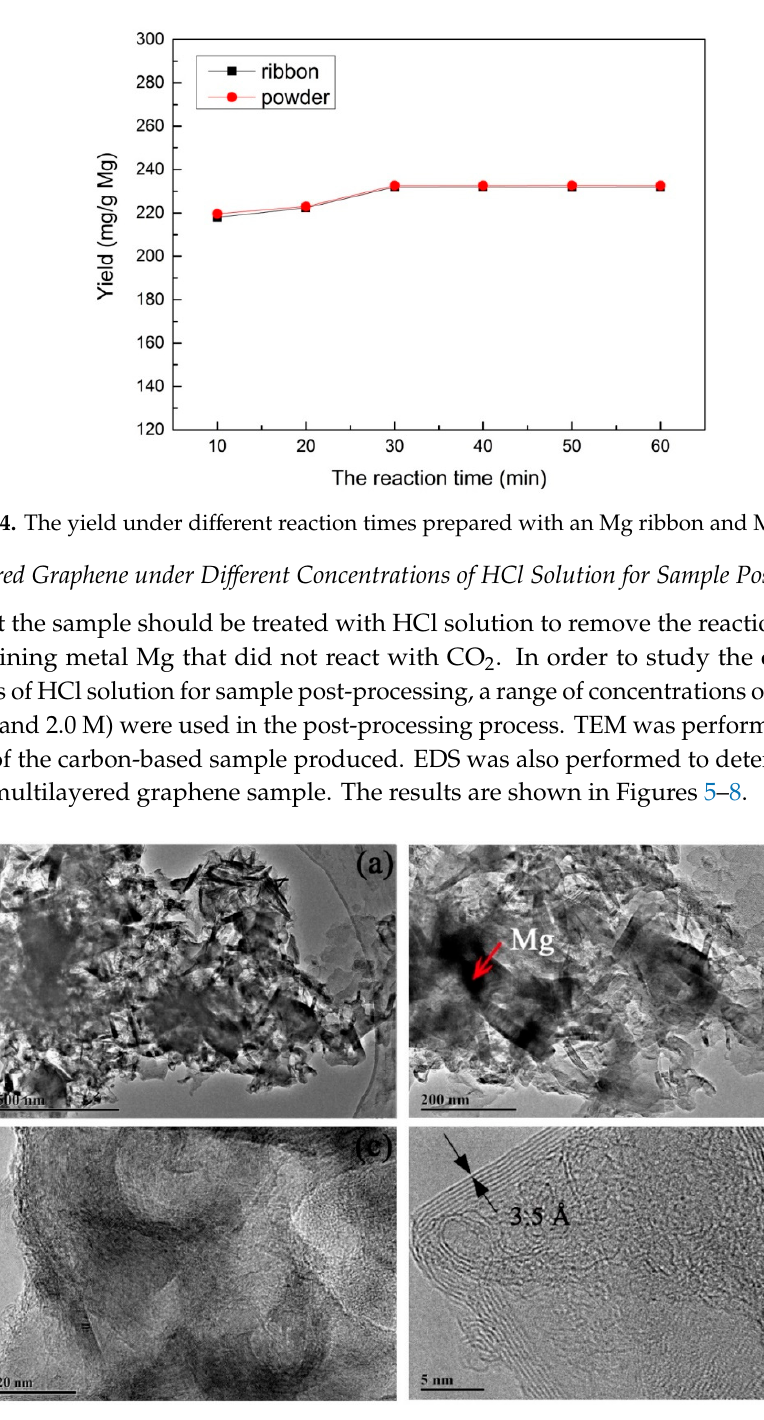
Figure 5. Transmission electron microscopy (TEM) images of multilayered graphene treated with 0.5 M concentration of HCl. ( a ) Thin graphene sheets aggregates. ( b ) The composition of multilayered graphene. ( c ) Typical stripe structures that occurred on the surface of the sample. ( d ) A high-resolution TEM image of multilayered graphene.